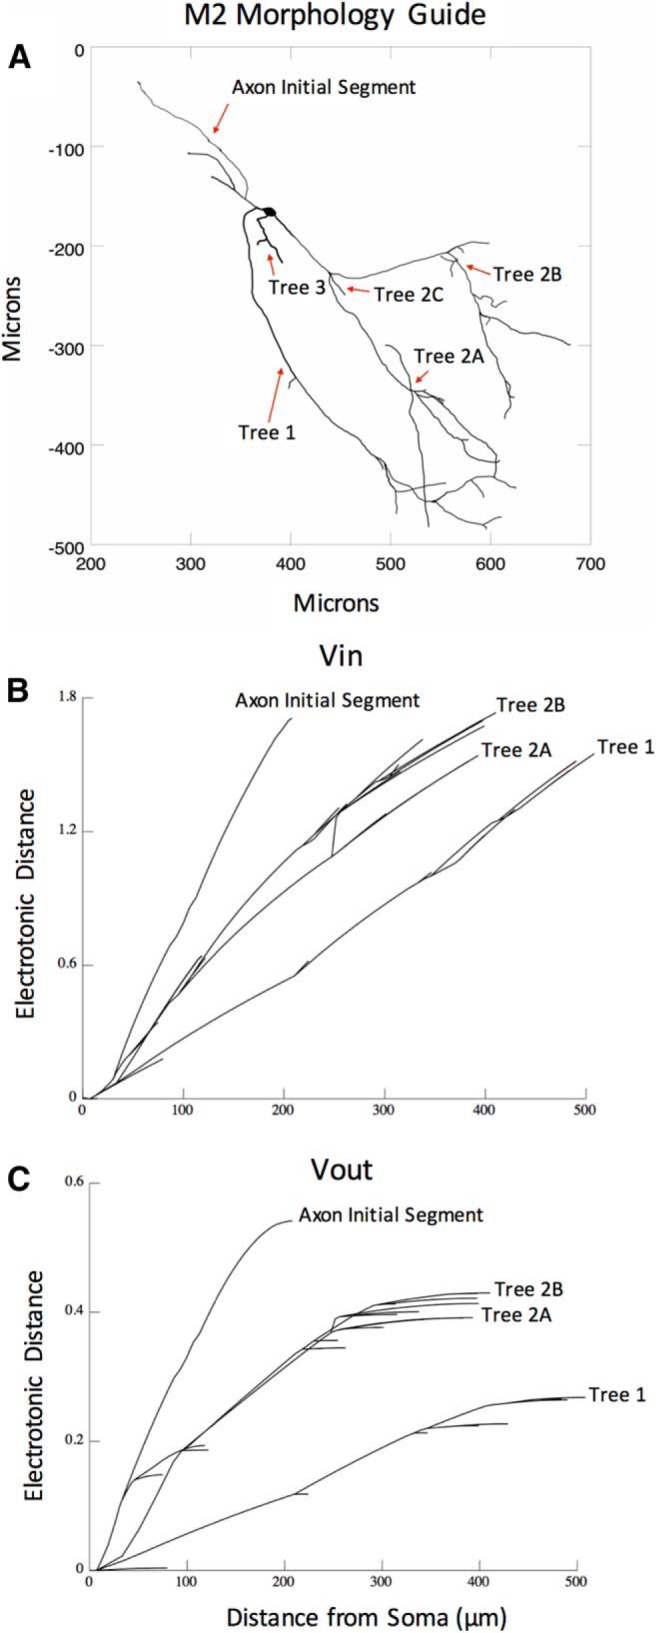
Electrotonic analysis of the M2 morphology. A, A guide of the M2 morphology designating all of the morphological subsections, as well as showing both the spatial scale and diameter. B, Electrotonic distance along the dendritic arbor for voltage flowing into the soma. C, Electrotonic distance along the dendritic arbor for voltage flowing away from the soma. Note that the electrotonic distance is equal to the log value of attenuation, where attenuation is measured as voltage upstream/voltage downstream. More specifically, voltage upstream is an applied 1 mV signal, and voltage downstream is the downstream response to the 1 mV signal. In this sense, electrotonic distances >1 would imply a 10-fold attenuation in the signal.